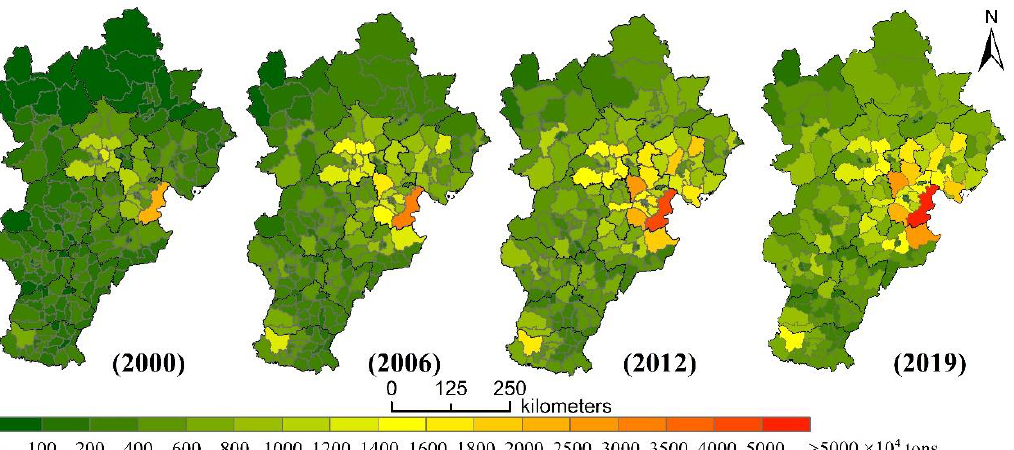
Figure 9. County-level CO 2 emissions in the Beijing – Tianjin – Hebei region in 2000, 2006, 2012 and 2019.